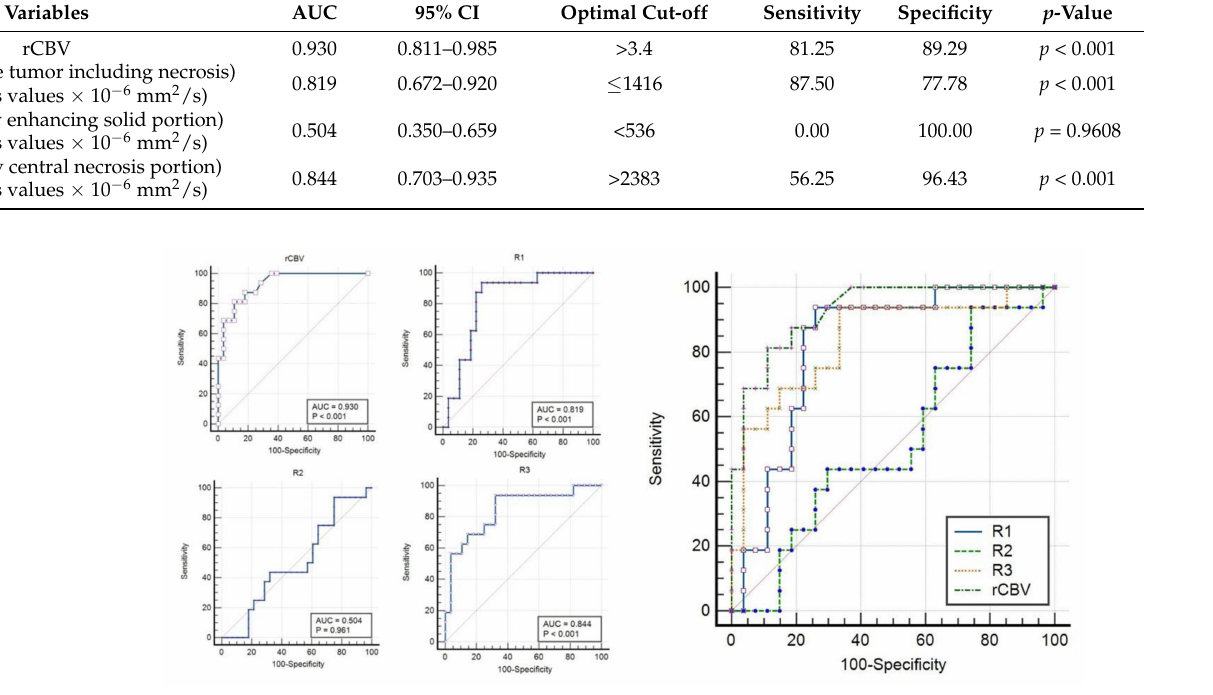
Figure 2. Receiver operating characteristic (ROC) curves with area under the curve (AUC) for both rCBV, ADC R1, R2, R3 ( left ) and comparison of ROC ( right ). Details of AUC with 95% CI and p values for comparison are provided in Table